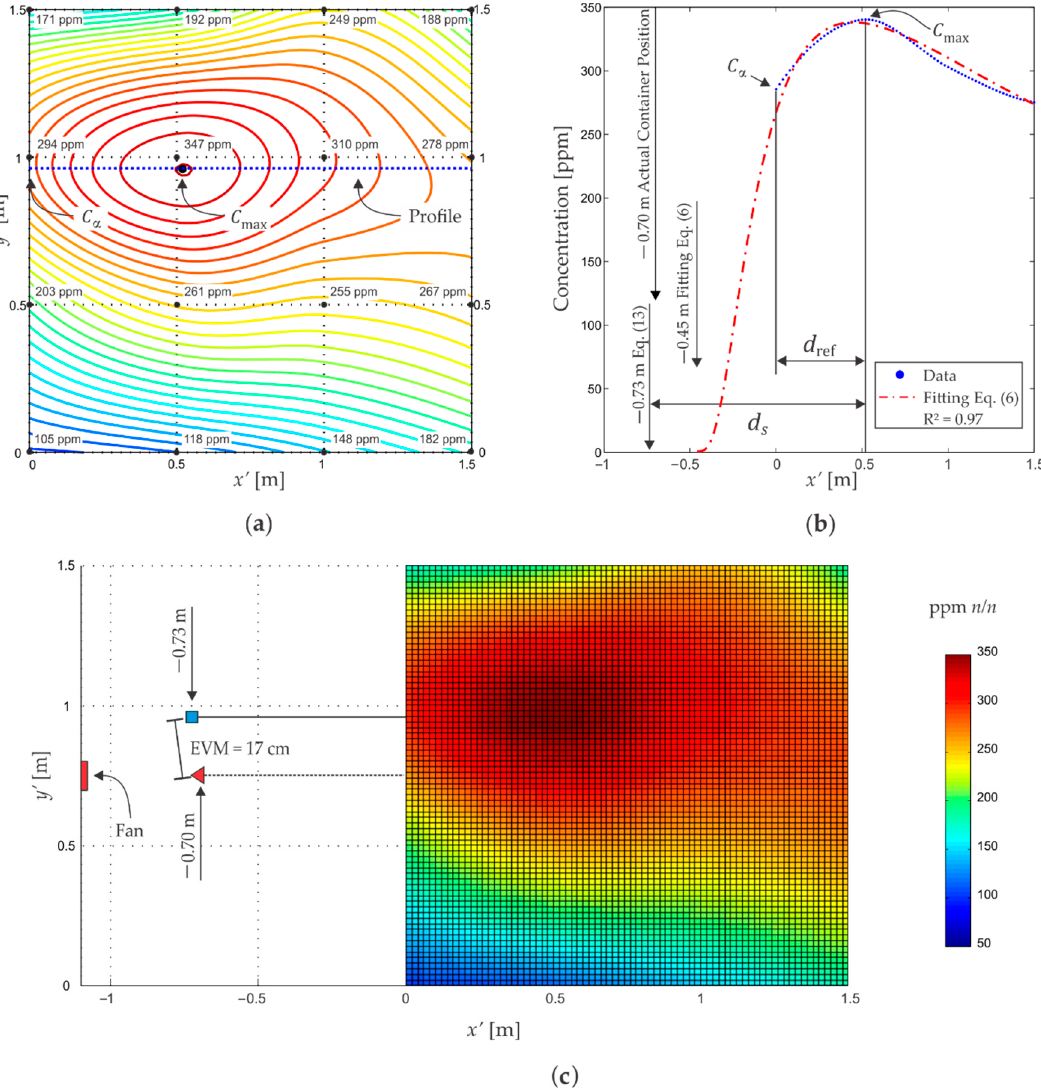
Figure 10. Concentration distribution data for a particular path. ( a ) Isoconcentration lines and plume symmetry axis. The average concentration values in each stop are also shown; ( b ) Dotted line, concentration profile along the symmetry axis obtained from interpolation. Dashdotted line, fitting using the whole measured profile; ( c ) Container position: the triangle shows the center of the container and the square indicates the estimated position according to Equation (13).